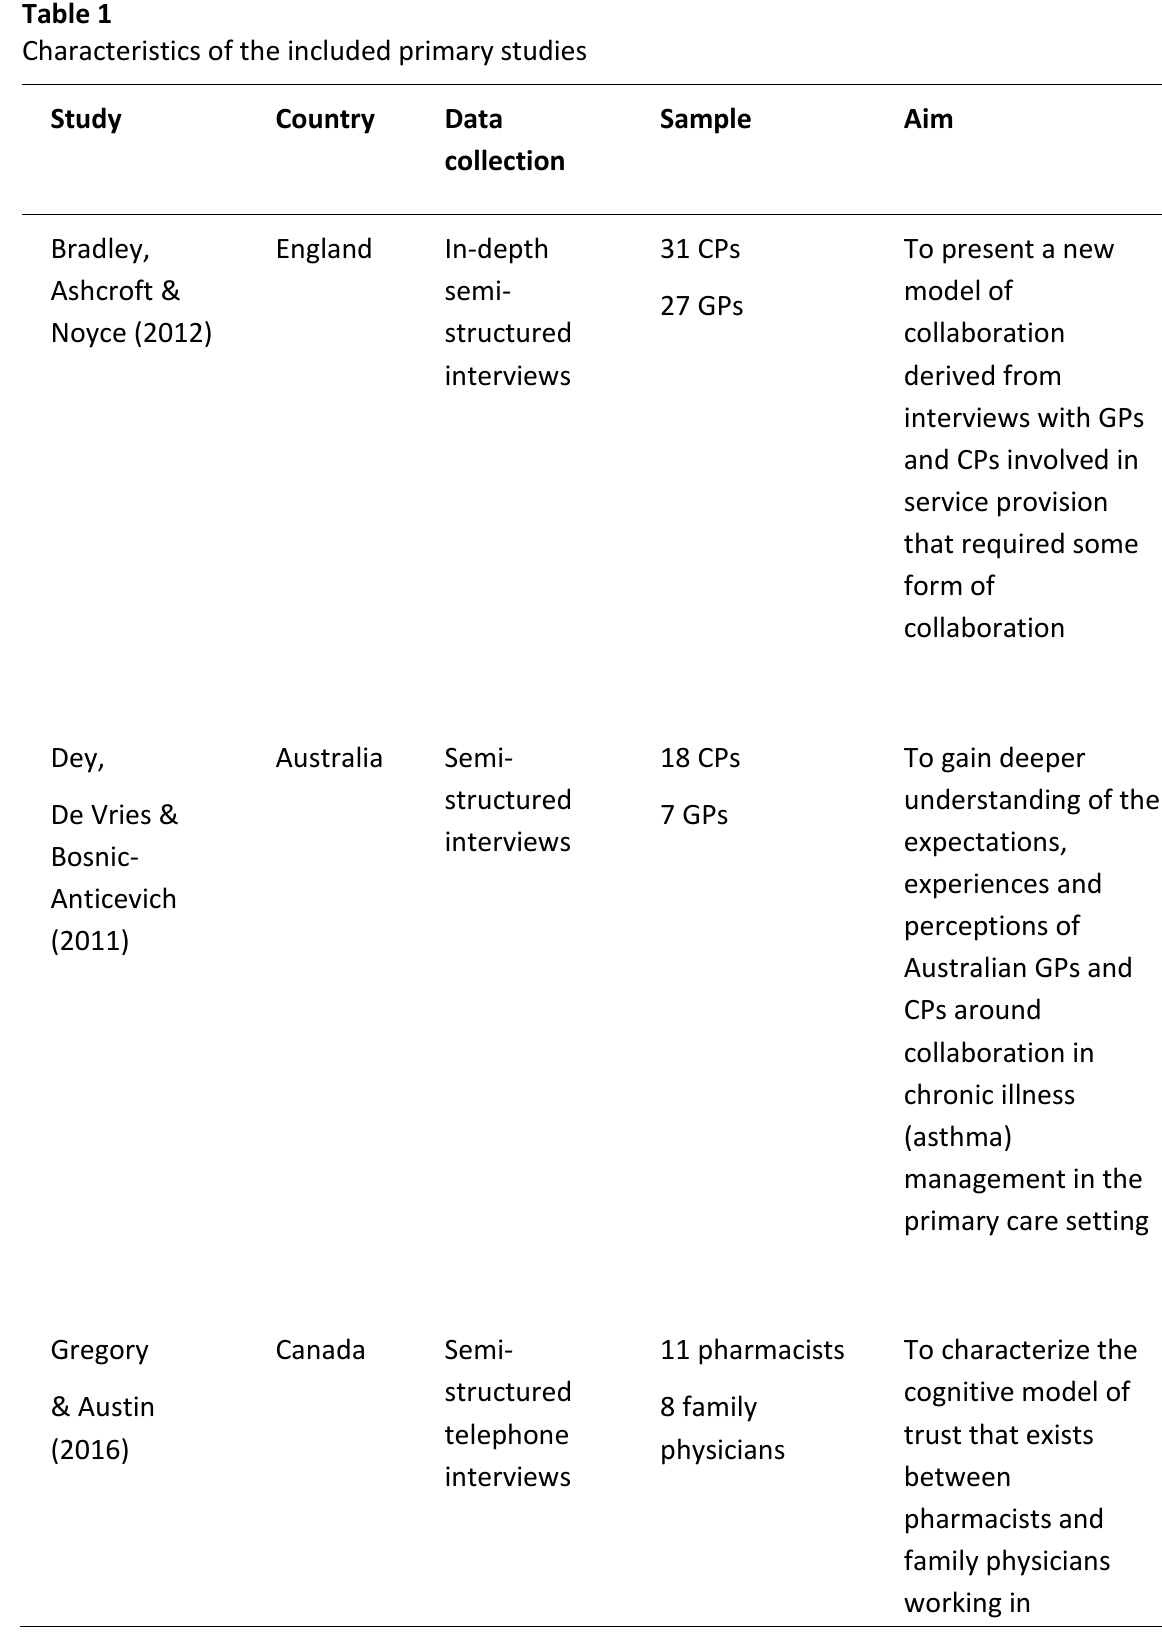
Table 1 Characteristics of the included primary studies